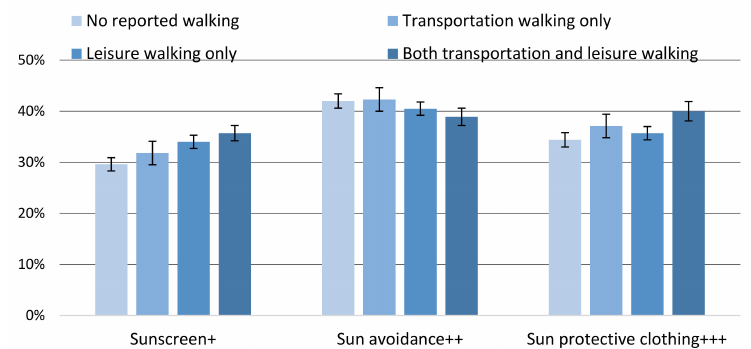
Figure 1. Weighted a and adjusted b prevalence (%) of U.S. adults age ≥ 18 years who reported regular sunscreen use c , sun avoidance d , and sun protective clothing e by walking category f , National Health Interview Survey, 2015. ( + no reported walking vs. both, p < 0.0001; no reported walking vs. leisure, p < 0.0001; transportation vs. both, p < 0.01. ++ no reported walking vs. both, p < 0.01. +++ no reported walking vs. both, p < 0.0001; no reported walking vs. transportation, p < 0.05; transportation vs. both, p < 0.05; leisure vs. both, p < 0.01. a 95% confidence interval. b Covariates: Gender, age, ethnicity, education, marital status, foreign-born status, needs walking assistance, U.S. Census region, obesity or overweight, physical activity level, smoking status, binge drinking, tanning bed use, ever had a skin exam, ever had cancer, family history of melanoma, personal history of melanoma, sunless tanning product use, sunburn previous 12 months, skin reaction to sun after two weeks, and health insurance status. c Regular sunscreen use was defined as always or usually using sunscreen with SPF15 + (sun protection factor). d Response of always or usually staying in the shade or responding not going into the sun for any sun protective question. e Response of always or usually wearing long sleeve shirt, long clothing to the ankles, or a wide-brimmed hat on a warm sunny day. f Reported walking categories for at least 10 min in the past seven days.).